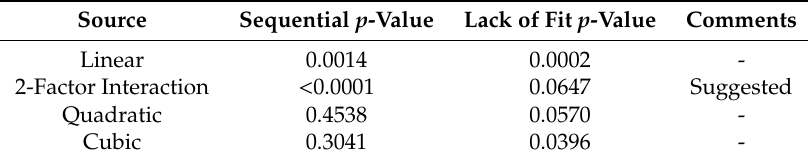
Table 4. Significance test for di ff erent flatness ratio model options.